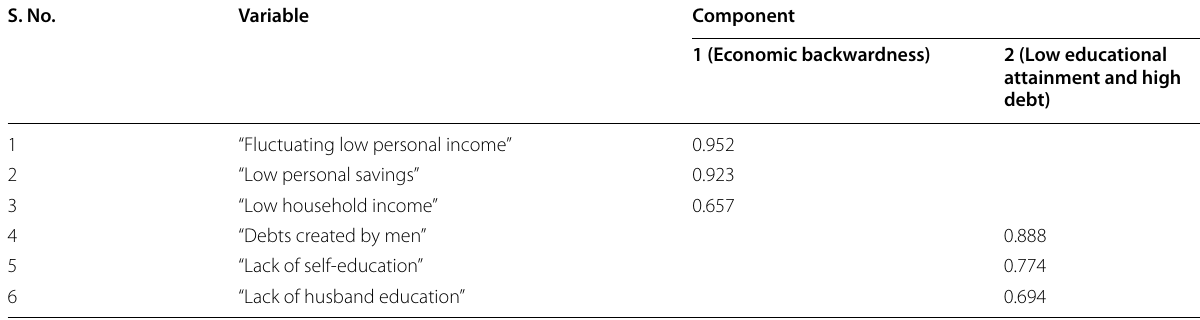
Extraction Method: Principal Component Analysis, and Rotation Method: Varimax with Kaiser Normalization